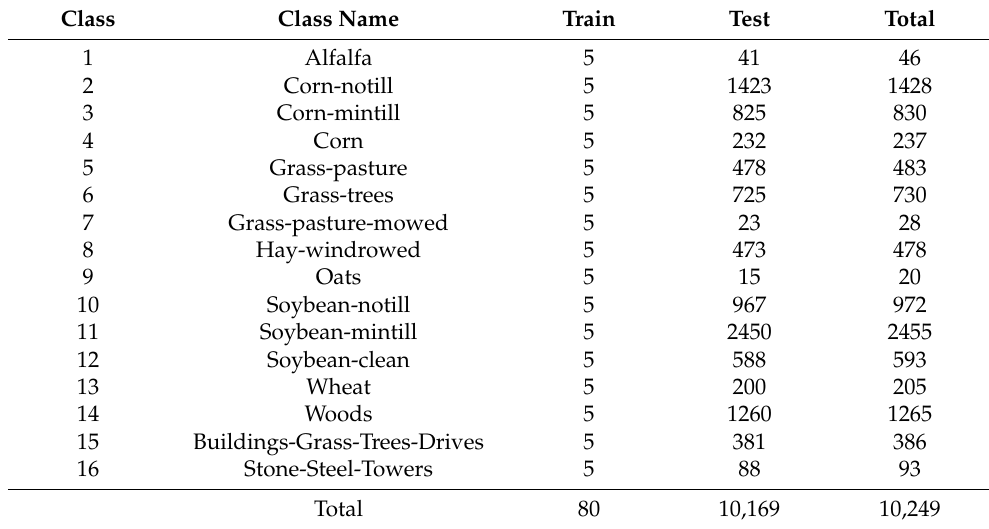
Table 1. The Numbers of Training, Testing, and Total Samples in IP Dataset.